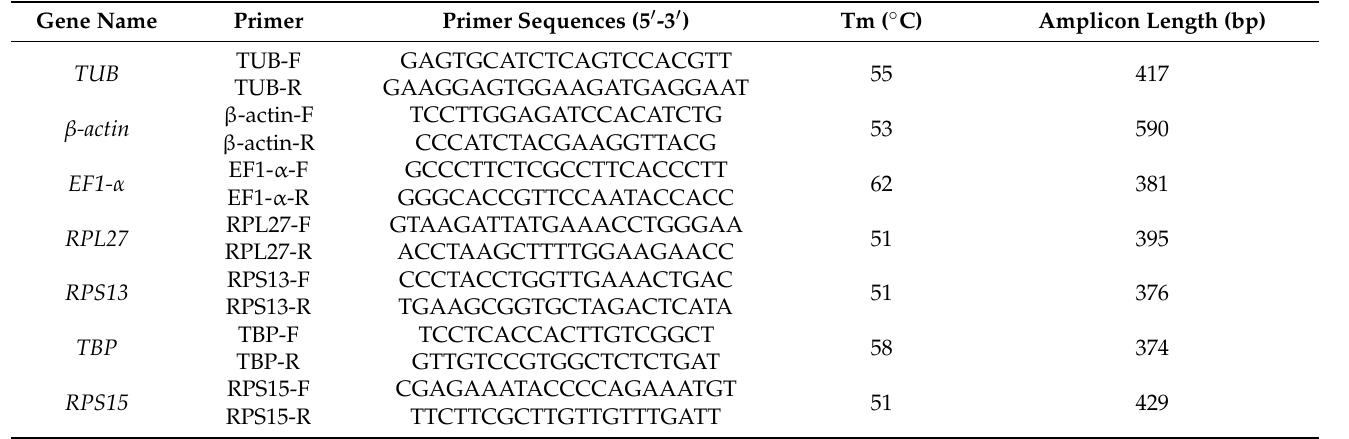
Table 1. Candidate reference genes and primers used in this